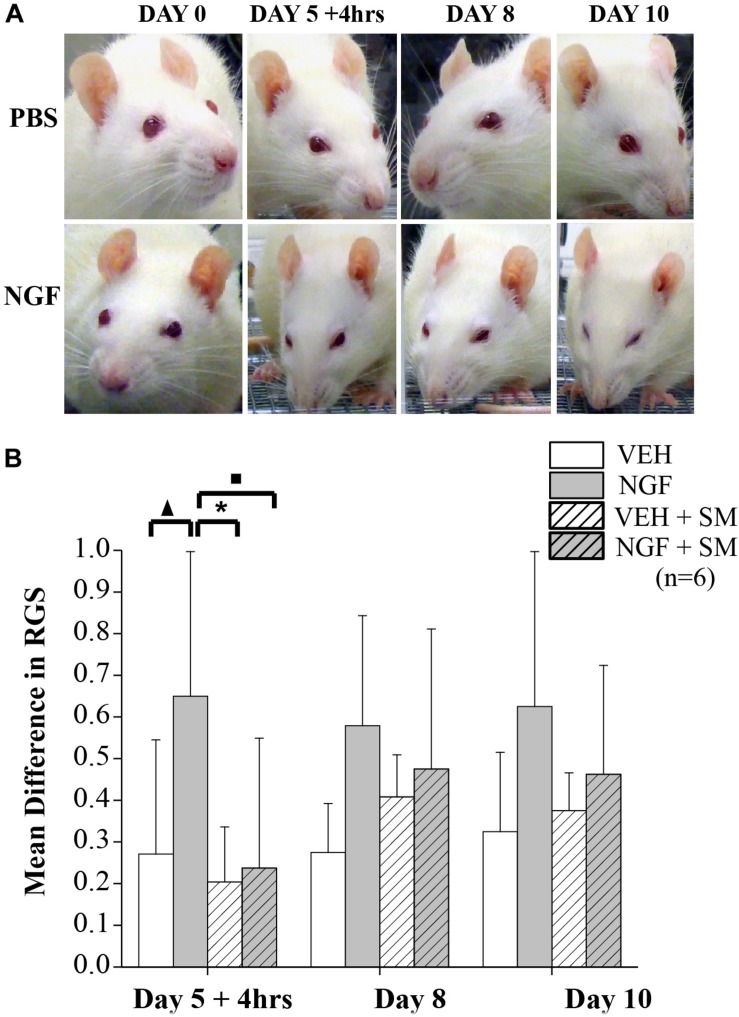
Rat grimace scale (RGS). (A) Representative images of facial grimacing observed due to NGF-induced low back pain. Four action units (orbital tightening, ear changes, cheek, and whisker change) are analyzed and scored. Note changes in spontaneous pain shown by orbital tightening and whisker retraction presented in the NGF group beginning as early as 4 h after the 2nd NGF injection delivered on Day 5. (B) Mean differences in RGS from Baseline on Days 5 + 4 h (4 h after 2nd NGF injection), 8 and 10. Compared to the VEH group the mean difference in RGS scores for the NGF group was significantly greater on Day 5 + 4 h (▲P = 0.03). Compared to the NGF group, the VEH + SM (*P = 0.01) and NGF + SM group (■P = 0.02) were significantly decreased. While the NGF group demonstrated higher mean RGS differences than other groups on Days 8 and 10, these changes did not reach statistical significance. Statistical analyses were performed by ANOVA followed by Tukey’s test and data reported as mean ± SD.